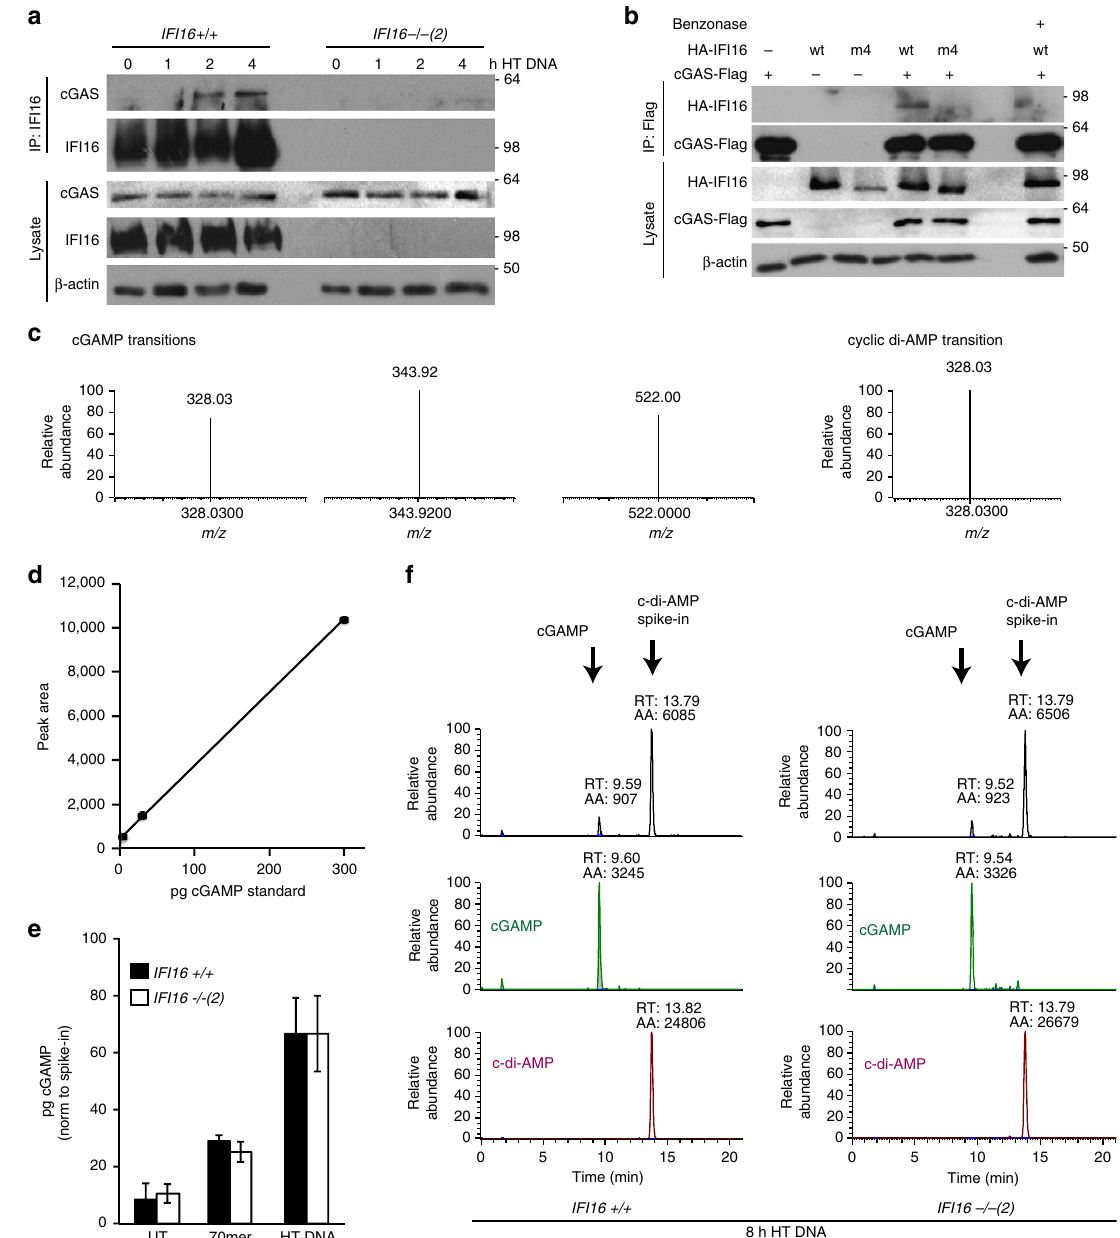
Figure 5 | IFI16 interacts with cGAS but does not affect cGAMP production. ( a ) IFI16 þ / þ or IFI16 (cid:2) / (cid:2) HaCaTcells were stimulated with 5 m gml (cid:2) 1 HT DNA for the times indicated, and IFI16 was immunoprecipitated from cell lysates. Lysates and immunoprecipitates (IP) were analysed by SDS–PAGE and western blotting. ( b ) HEK293Tcells were transfected with constructs for the expression of cGAS-FLAG and HA-IFI16, either wild-type (wt) or DNA-binding mutant (m4), as indicated. 24h post transfection, cells were subjected to lysis and immunoprecipitation using FLAG antibody. Immunoprecipitates were washed, and treated with benzonase where indicated. Lysates and immunoprecipitates (IP) were analysed by SDS–PAGE and western blotting. ( c ) Multiple reaction monitoring transitions for cGAMP and cyclic di-AMP, used for the quantification of endogenous cGAMP and internal standard cyclic di-AMP. m/z , mass/charge ratio of fragment ions. ( d ) Standard curve for synthetic cGAMP spiked into cell lysates before sample preparation and liquid chromatography and mass spectrometry (LC-MS) analysis. ( e ) IFI16 þ / þ and IFI16 (cid:2) / (cid:2) HaCaTcells were treated with 1 m gml (cid:2) 1 70mer oligonucleotide or HT DNA for 8h, followed by lysis in methanol, spike-in of c-di-AMP and sample preparation. cGAMP levels were determined by LC-MS, and normalized to c-di-AMP levels to account for losses in sample preparation and injection. Data are representative of at least four experiments; values are shown as mean of triplicate samples, with error bars representing s.d. ( f ) Total and extracted ion chromatogram of cGAMP and cyclic di-AMP in representative samples from ( e ), showing IFI16 þ / þ and IFI16 (cid:2) / (cid:2) cells treated with HT DNA for 8h. AA, integral peak area; RT, retention time.